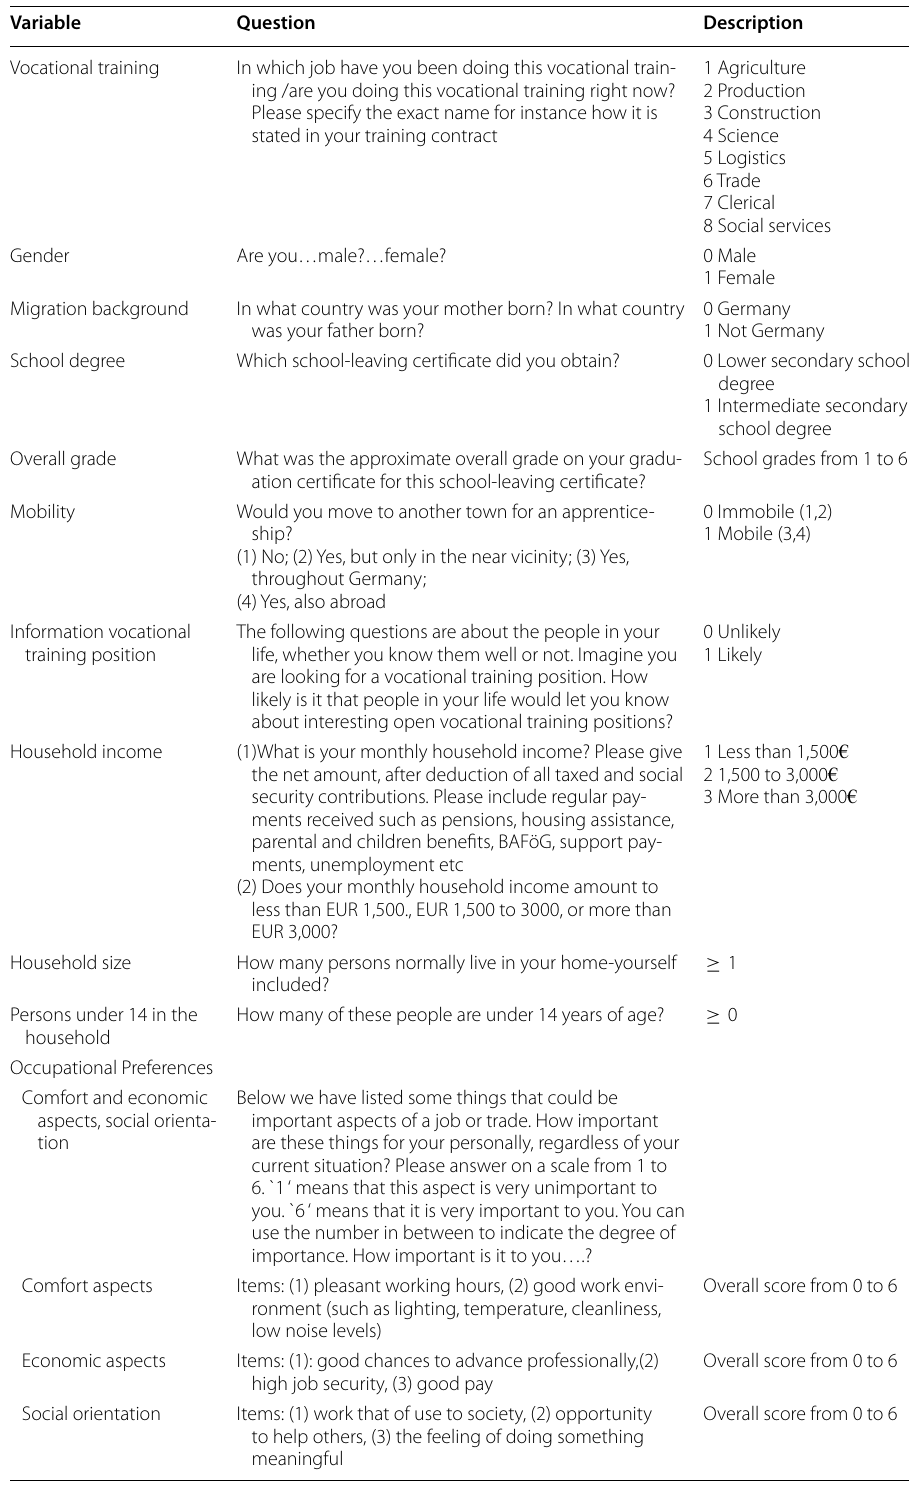
Table 9 Variables in the NEPS data and their